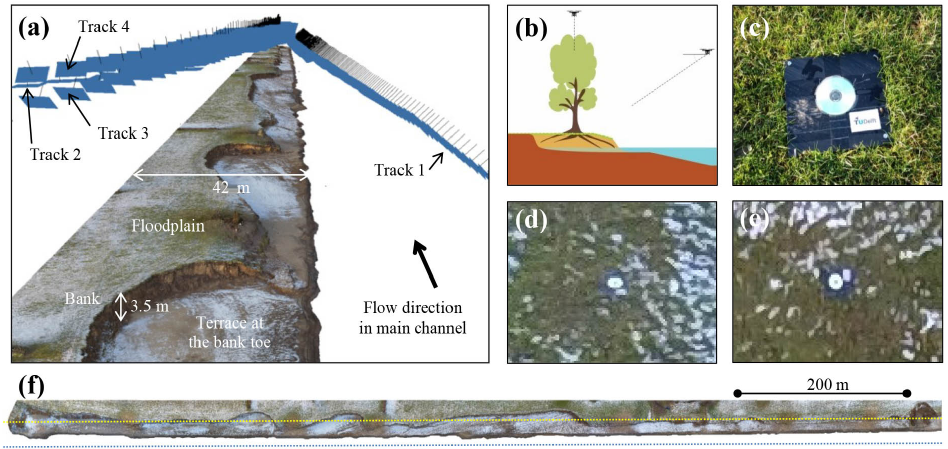
Figure 3. (a) Camera positions and orientations in perspective view. The digital surface model shows the low water condition during January 2017, which exposed a terrace at the bank toe. (b) Cross-sectional scheme of UAV paths. (c) Ceramic plaque with CD as ground-control point on the floodplain. (d) GCP in photograph from track 1. (e) Same GCP from track 2. (f) Top view of DSM with UAV track 1 in blue and tracks 2–4 in